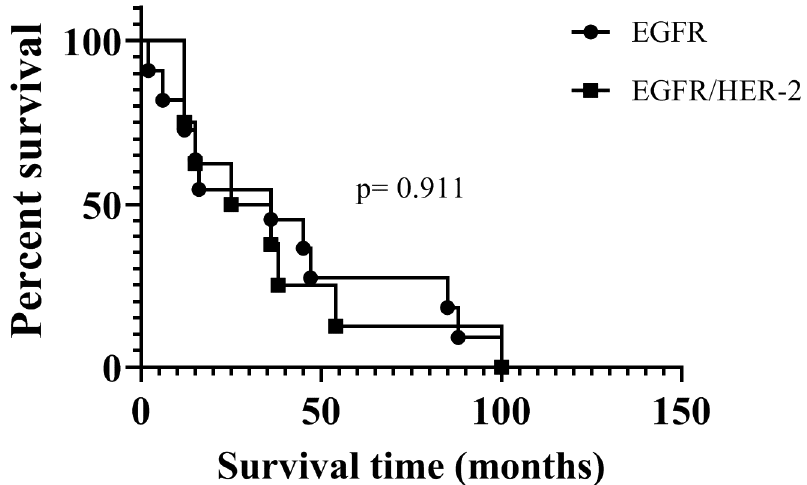
Figure 5. Comparison of patient’s survival time between ascitic fluid derived cells with positive staining for EGFR and EGFR and HER-2 proteins. There is no significant statistical difference between two groups of patients ( p = 0.911). The statistical analysis was performed by using Log-rank (Mantel – Cox) and Gehan – Breslow – Wilcoxon tests, available from a GraphPad Prism 8.0.1 version.